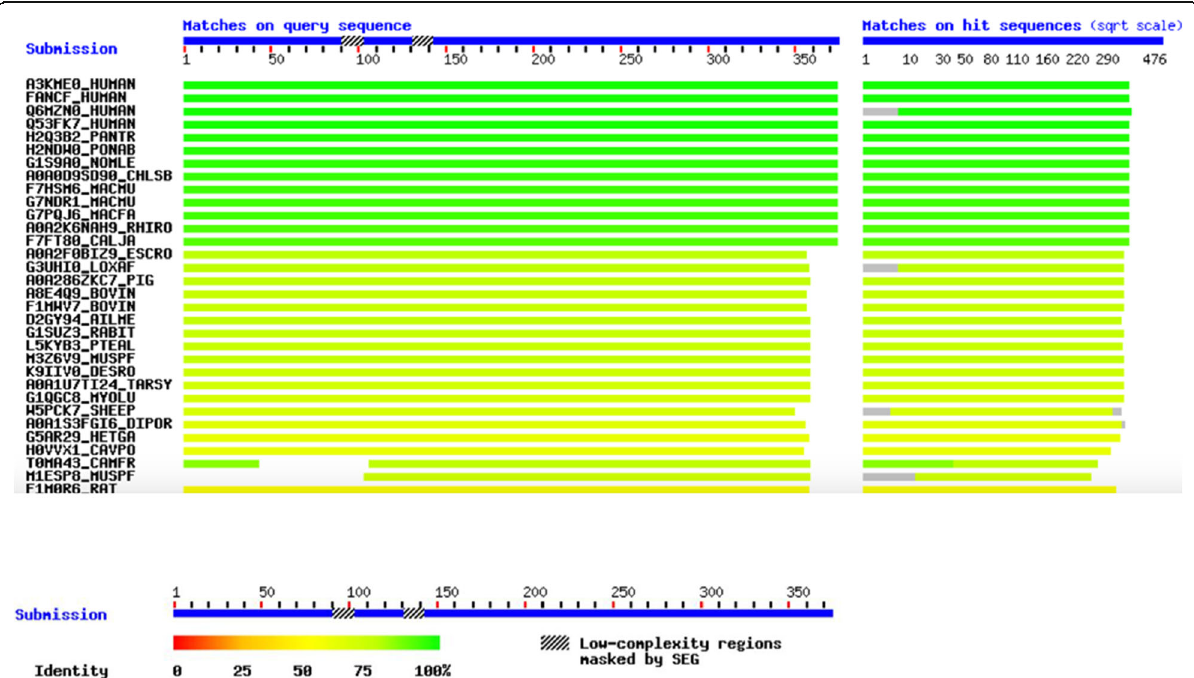
Fig. 3 Multiple protein sequence alignment of FANCF across different